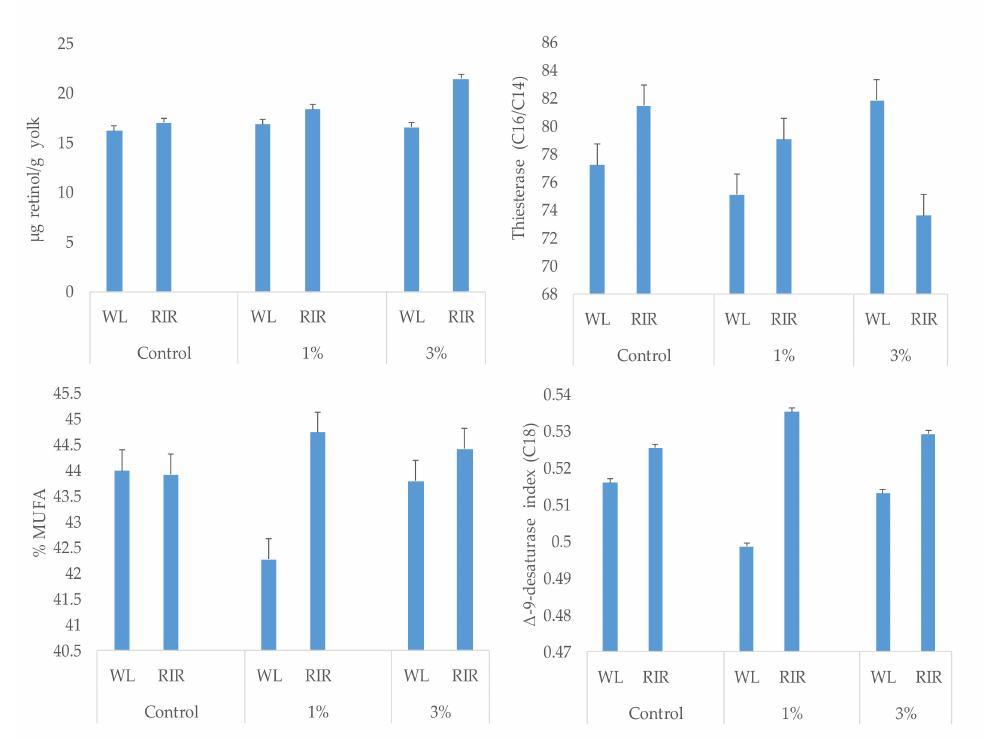
Figure 1. Interaction effect ( p < 0.05) in yolk retinol content, monounsaturated fatty acids (MUFA) proportion, ∆ 9-desaturase and thiesterase indices according to spirulina supplementation and hen strain (White Leghorn: WL or Rhode Island Red: RIR).